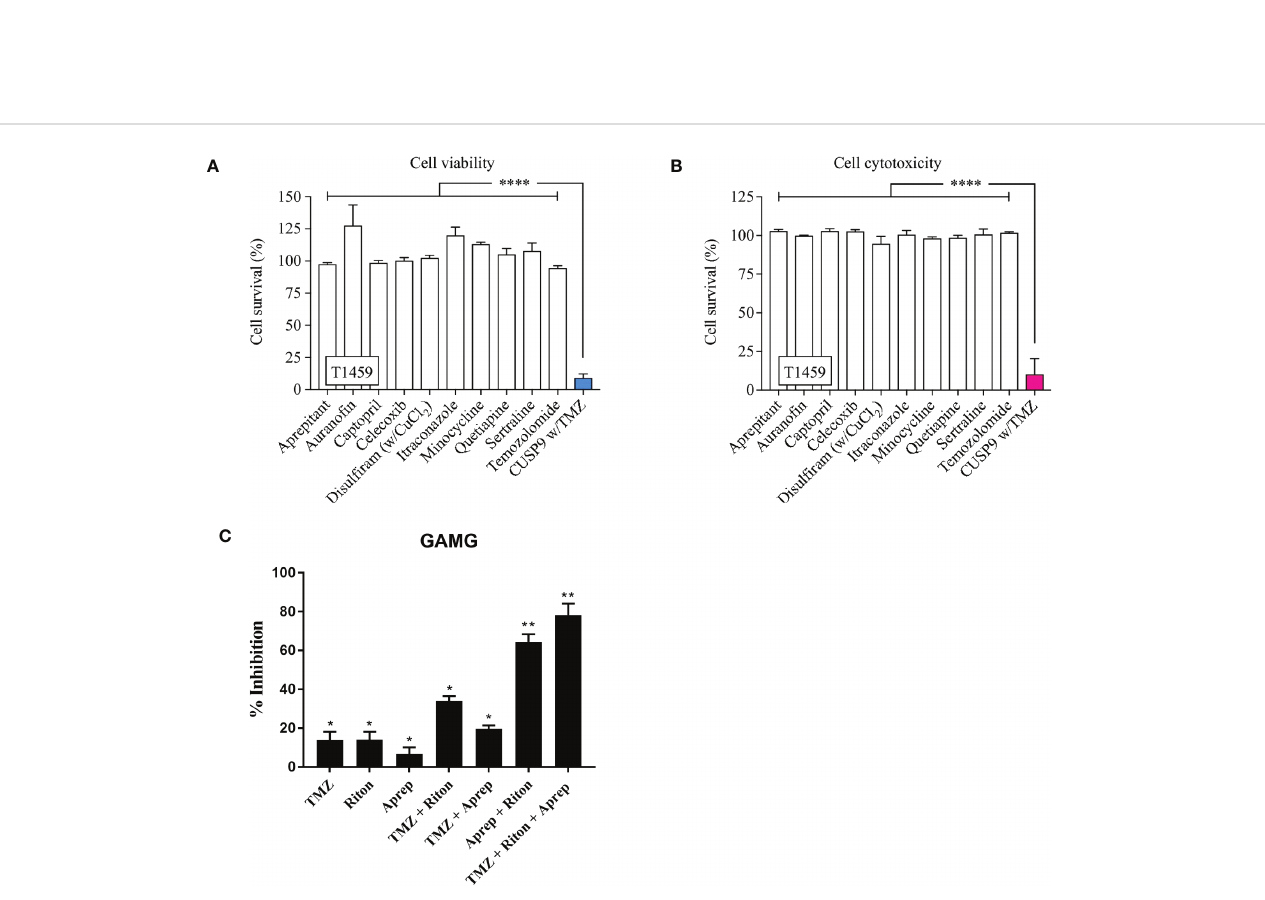
FIGURE 3 CUSP9 with TMZ. (A, B) Individually, the drugs in the CUSP9 or TMZ did not reduce cell survival, evaluated by the cell viability or cytotoxicity assay; a signi fi cant effect was observed when applied as a drug combination in CPCs (**** p <0.0001, one-way ANOVA). (C) Percentage of growth inhibition of human GAMG cells following the addition of temozolomide (TMZ), ritonavir (Riton) and aprepitant (Aprep) in monotherapy; temozolomide + ritonavir, temozolomide + aprepitant and aprepitant + ritonavir in combination therapy (* p <0.05, ** p < 0.01). Adapted from Skaga E., et al., 2019 (132) and Kast R.E., et al., 2016